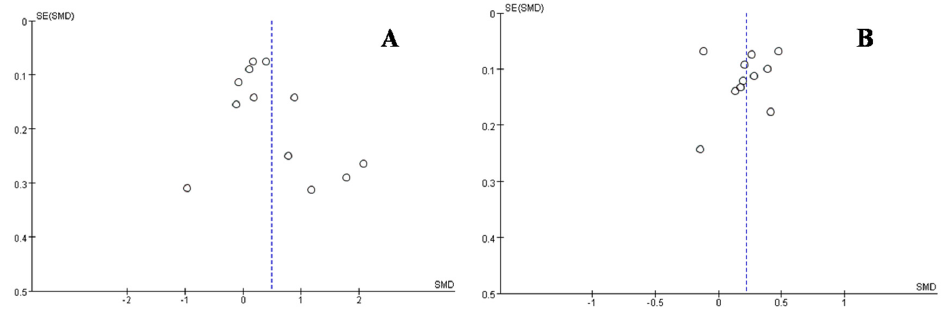
Figure 13. Funnel plot for the percentage of monomethyl arsenic (MMA%) that was affected by both arsenic exposure ( A ) and smoking ( B ). Blue-dotted line shows the overall estimated standard mean difference. Evidence for publication bias was not found. SMD, standard mean difference; SE, standard error.